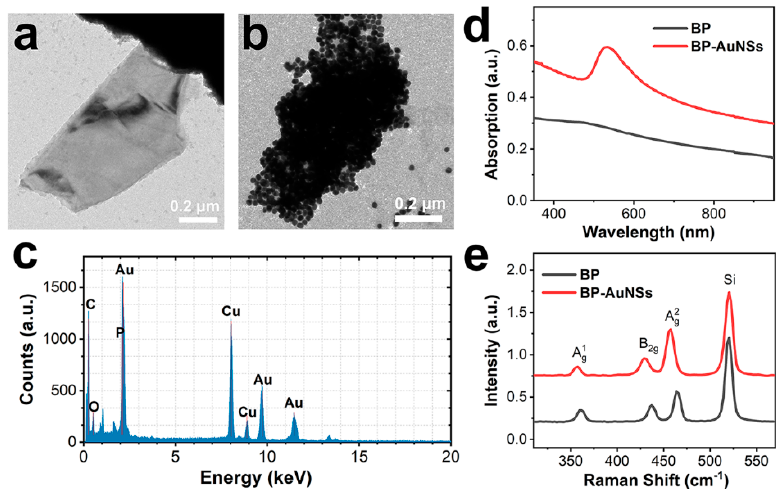
Figure 1. Transmission electron microscopic (TEM) images of black phosphorus (BP) sheet ( a ) and BP-AuNSs ( b ). ( c ) EDX pattern of BP-AuNSs. ( d ) Ultraviolet-visible-near infrared (UV-vis-NIR) absorbance spectra of the nanostructures. ( e ) Raman spectra of BP and BP-AuNSs.